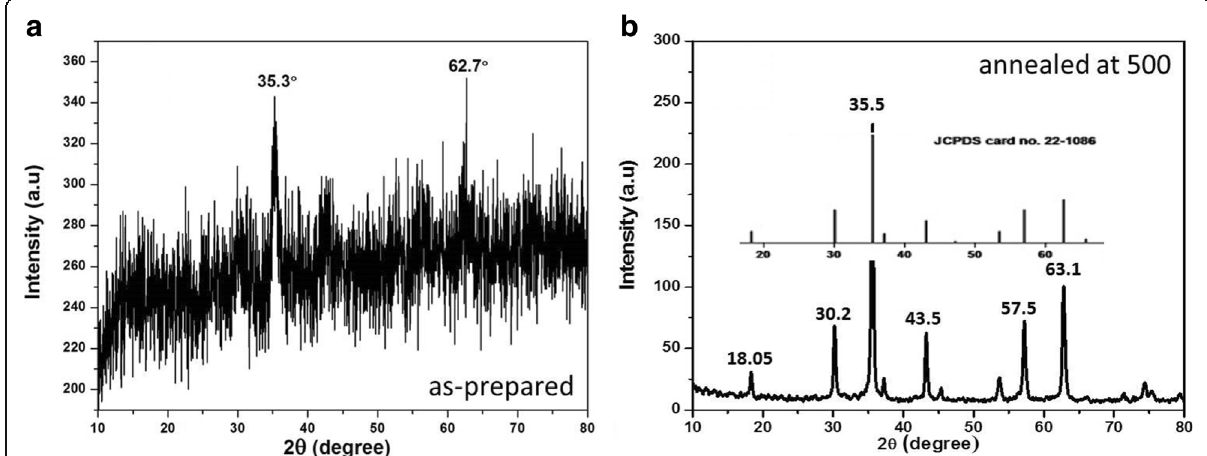
Fig. 2 XRD results of the samples a as-prepared and b annealed at 500 °C. The inset shows the JCPDF card for cobalt ferrite. No extra peaks can be seen in the obtained XRD data